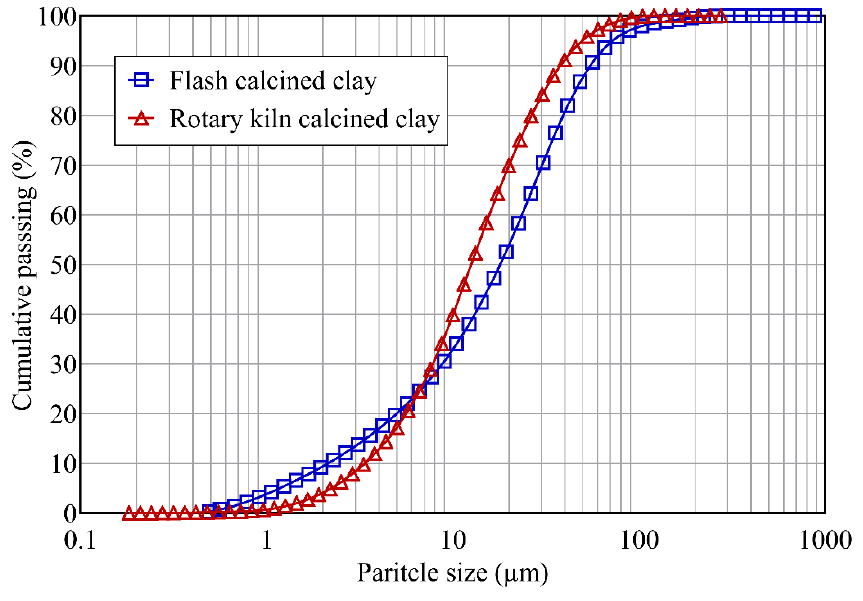
Figure 3. Particle size distribution of calcined clays.